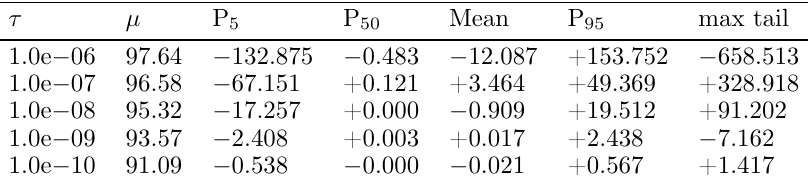
Table 10. Error on k ∞ in pcm after lossy compression by truncated HT on the UGd dataset with matrices M per reaction type only.